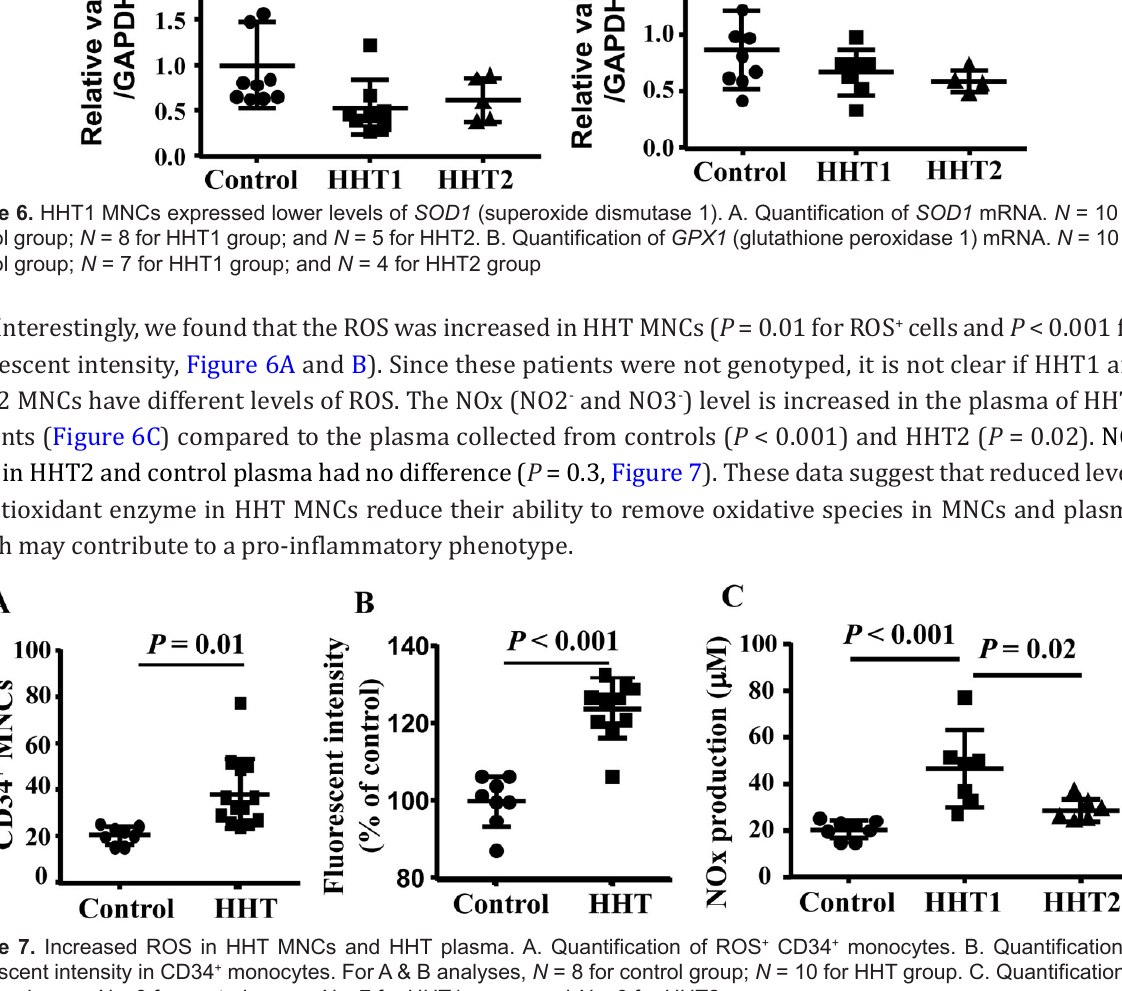
fluorescent intensity in CD34 + monocytes. For A & B analyses, N = 8 for control group; N = 10 for HHT group. C. Quantification of NOx in plasma. N = 8 for control group; N = 7 for HHT1 group; and N = 6 for HHT2 group